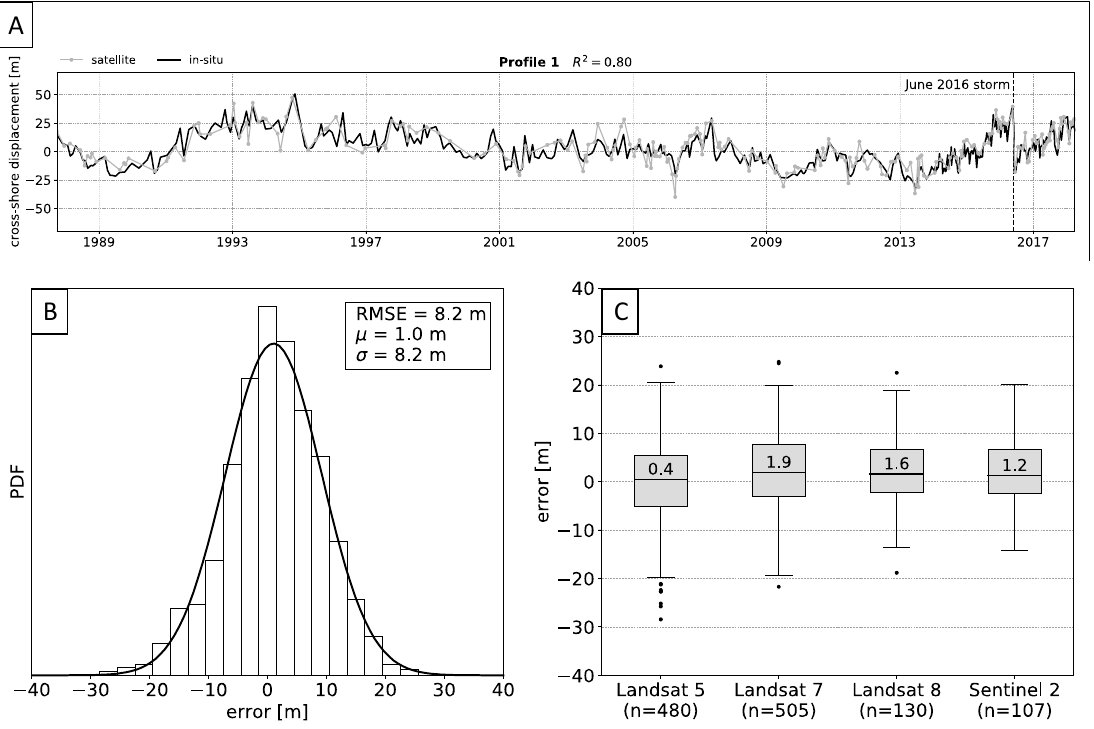
Figure 9. ( A ) timeseries comparison for profile 1; ( B ) Horizontal accuracy of the satellite-derived shorelines for Narrabeen (all 5 profiles); ( C ) boxplots of the error distribution as a function of satellite mission. Source: Vos et al. [98].